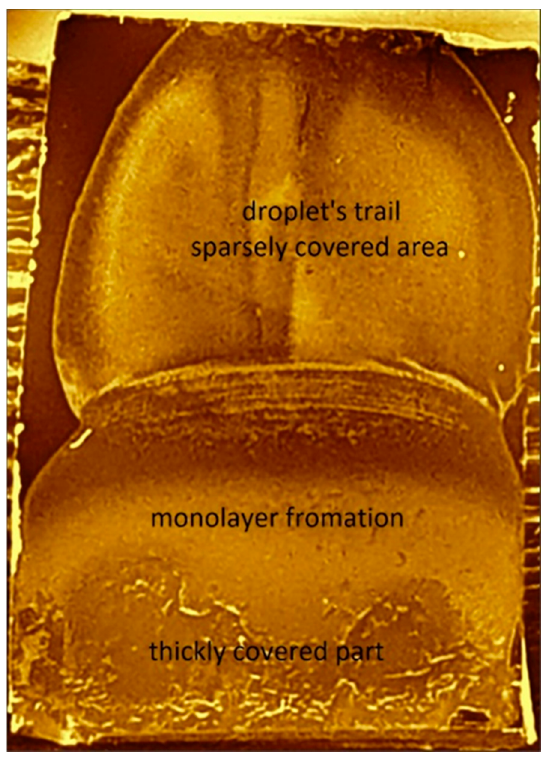
Figure 5. Substrate regions of different coverage formed upon drop casting at an angle.